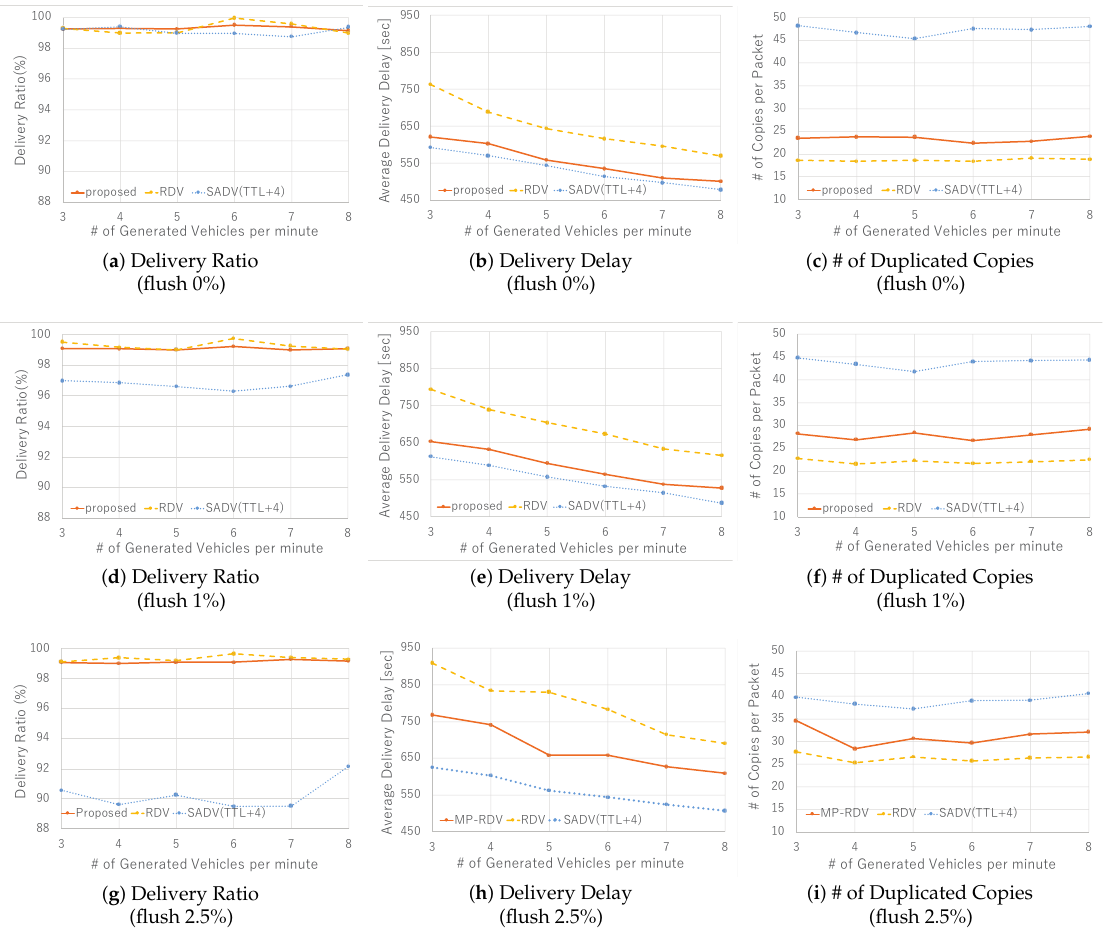
Figure 11. Performance with various vehicle density: delivery ratio, delivery delay, and the number of duplicated copies are measured for each flush rate 0%,1%, and